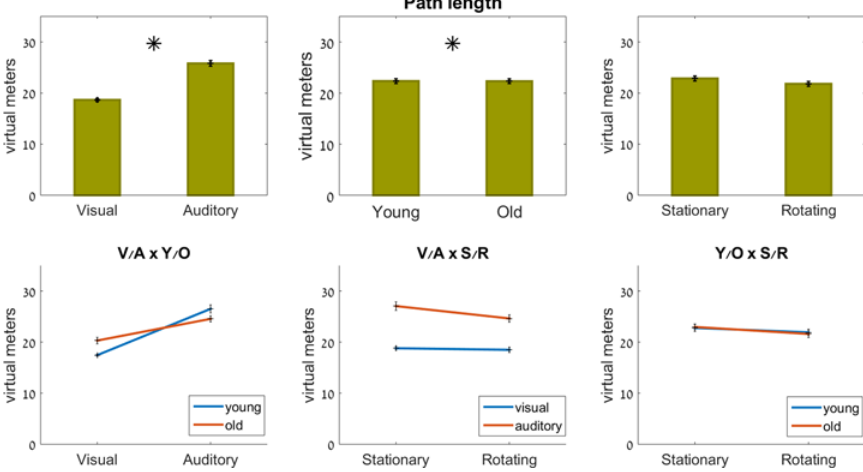
Fig 6. Path length. Top row: main effects; bottom row: interaction effects (ns). Significant effects marked with an asterisk.